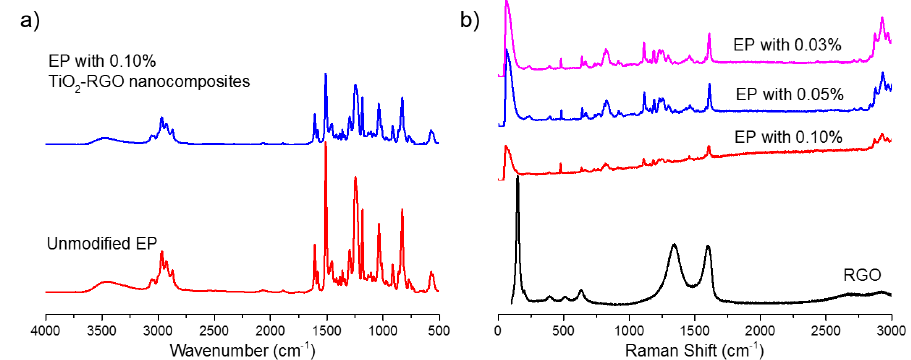
Figure 7. FTIR ( a ) and Raman spectra ( b ) of unmodified EP and TiO 2 -RGO-EP composites.